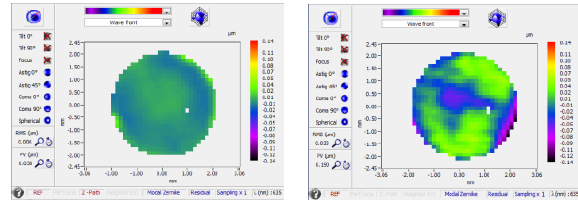
Fig. 4. (Left) Residual aberration in transmission at 635 nm WFE = 6 nm RMS and (right) in reflection at 1064 nm WFE = 32 nm RMS